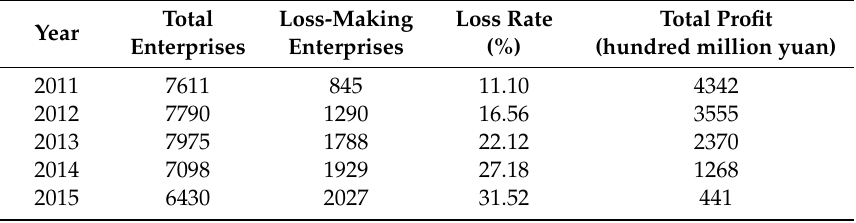
Table 1. Enterprises operating situation in China’s coal industry during 2011–2015.